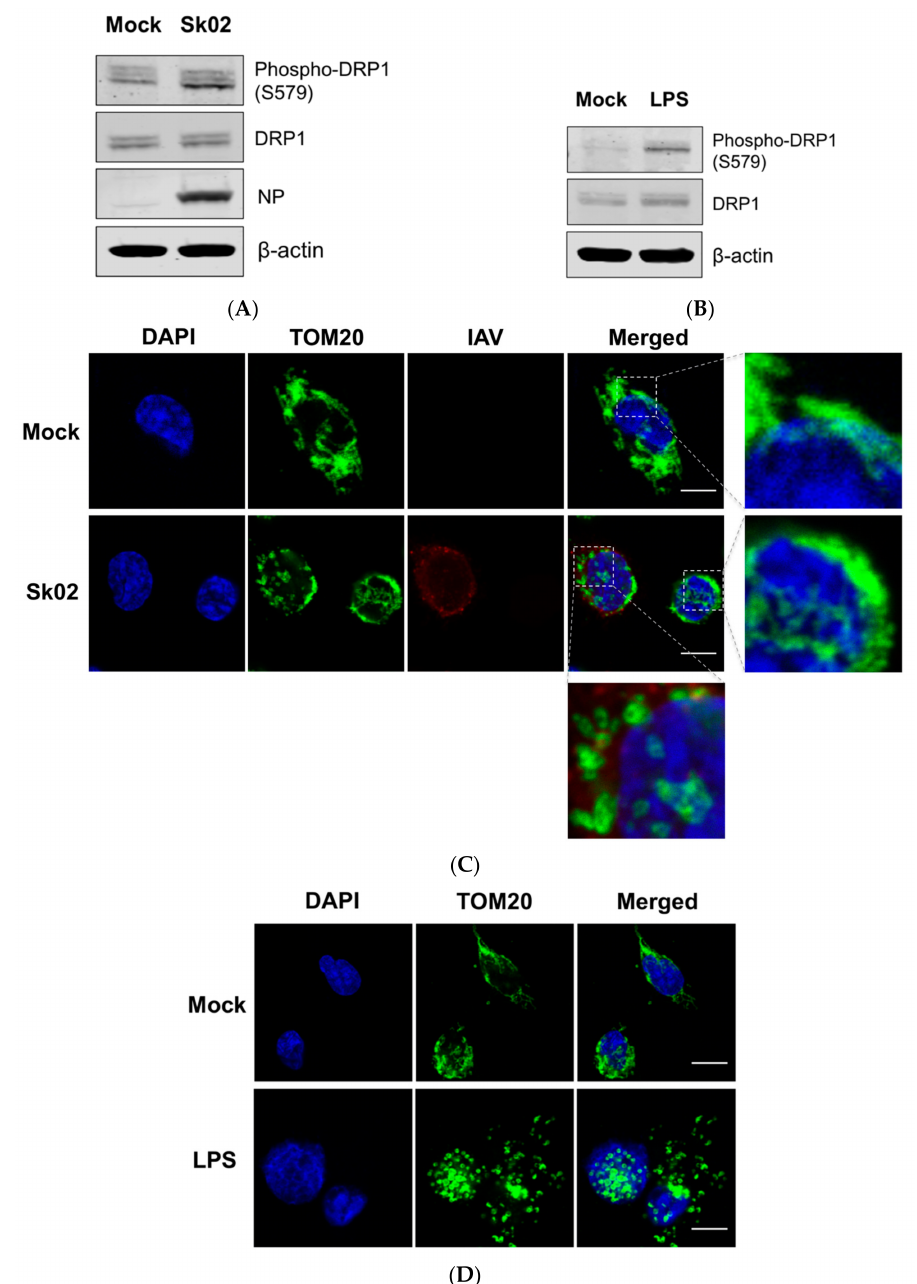
Figure 1. The swine influenza virus (SIV) infection induces dynamin-related protein 1 (DRP1) phosphorylation and mitochondrial fission in primary porcine alveolar macrophages (PAMs). PAMs were either infected with SIV Sk02 at an MOI of 1 for 4 h ( A ) or treated with 200 ng/mL lipopolysaccharide (LPS) for 12 h ( B ). Phospho-DRP1 at S579 and the total form of porcine DRP1 were detected by Western blotting. The viral NP protein was also monitored by Western blotting in infected cells. PAMs were either infected with Sk02 at an MOI of 1 for 7 h ( C ) or treated with 200 ng/mL LPS for 16 h ( D ). Immunofluorescence and confocal microscopy were performed using an antibody against the mitochondrial protein, TOM20, and the influenza A virus (IAV) antibody, when infected. Nuclei were stained by DAPI. Boxed areas were magnified and displayed on the right side (for a mock or un-infected cell) or below (for an infected cell) the corresponding panels in ( C ). Scale bar, 10 µ m. Results are representative of three independent